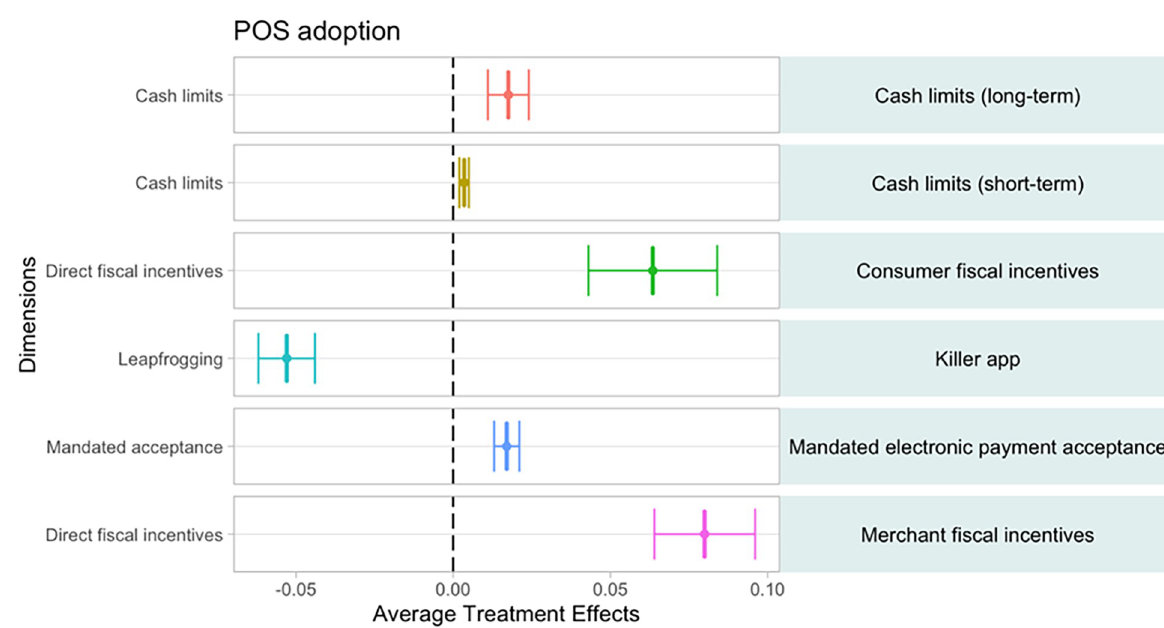
Fig 4. Impact of incentives: Treatment effects on pos terminal adoption (merchant level sample).